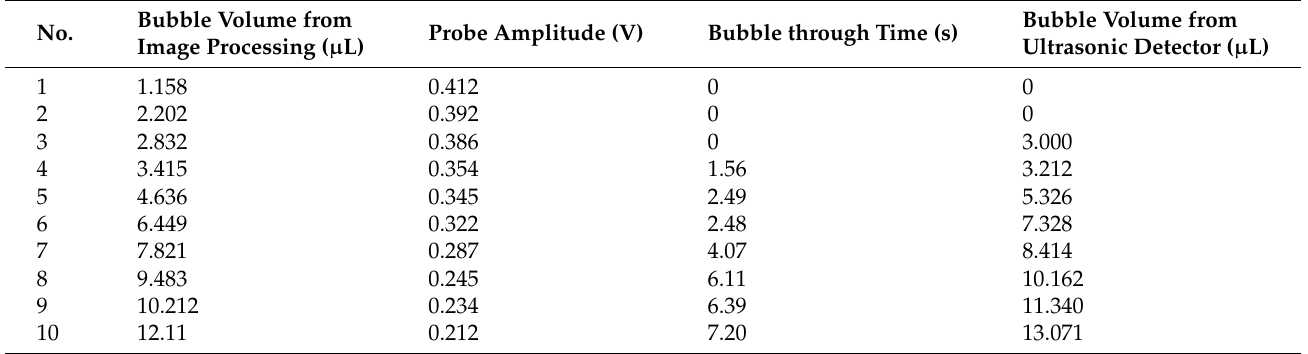
Table 1. The detected bubble volume of the bubble-detection system.